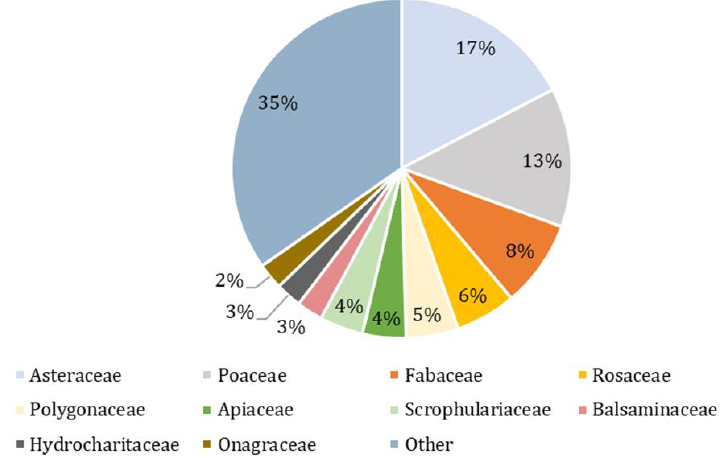
Fig. 3. The families most frequently represented among invasive alien plant species in Poland